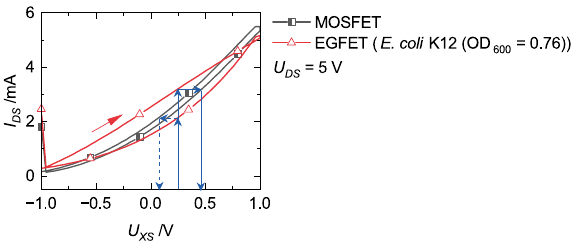
Figure 9. Determination of the floating-gate potential U FG with a transfer to the MOSFET’s characteristic symbolized by compact arrows for the forward sweep and dashed arrows for the backward sweep.